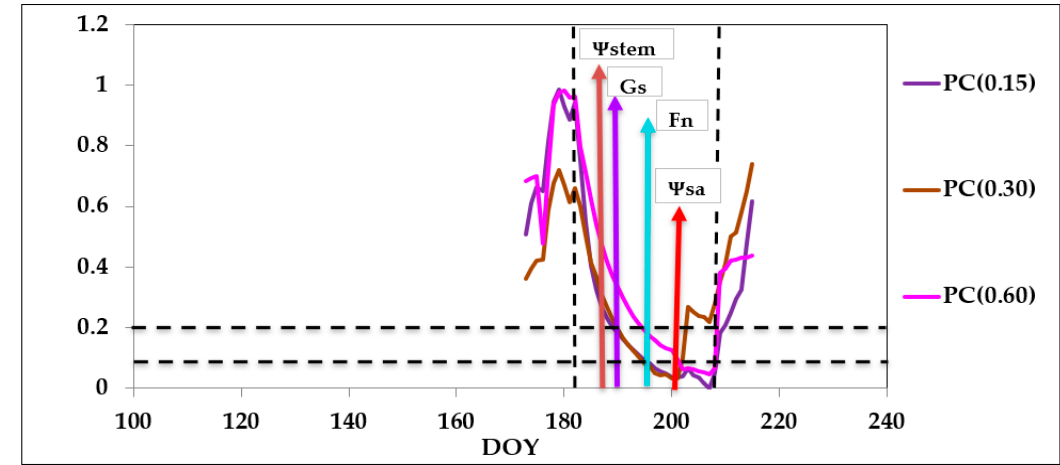
Figure 6. Temporal trends of soil moisture during the drying cycles in 2017 measured by FDR probes located in different positions. The black vertical line corresponds to the beginning and end of each drying cycle. The black horizontal lines correspond to the limits below which the RSWC value should not fall. DOY is day of the year; Ѱ stem is stem water potential; Fn is photosynthetic rate; Gs is stomatal conductance; Ѱ sa is the Ѱ stem recommended by Samperio et al. [24]. The arrows mark the soil mois- ture value when significant differences with the indicated physiological parameter are found or when the Ѱ sa is reached. PA, PB and PC are positions A, B and C, respectively, where the capacitance probes were installed. The depth in meters to which the probe was installed is shown in brackets. Values are averages of three FDR sensors.